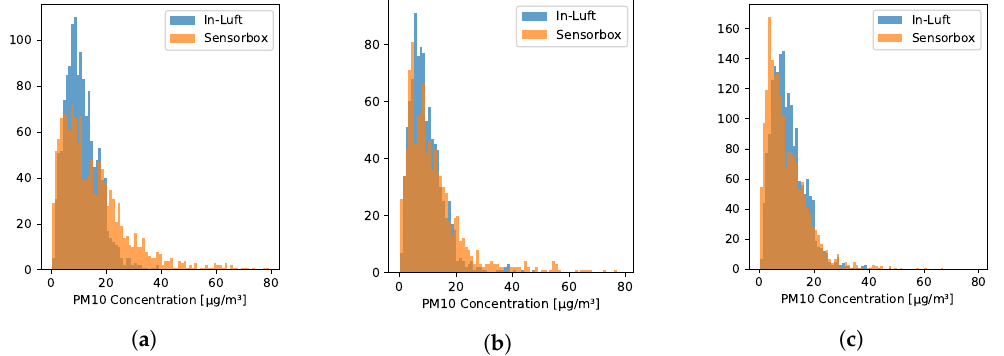
Figure 7. Distribution of hourly mean values of PM 10 concentration recorded in Stans, Nidwalden. ( a ) Sensor-box 1 recorded between 15 October 2021 and 23 December 2021; ( b ) Sensor-box 2 recorded between 17 November 2021 and 31 December 2021; ( c ) Sensor-box 7 recorded between 15